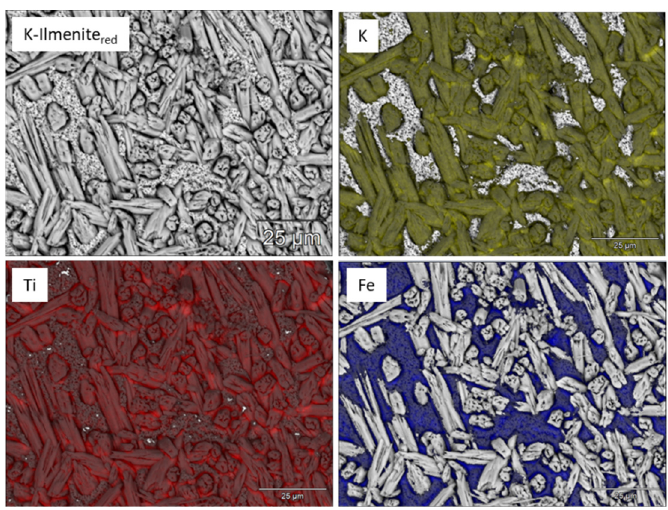
Figure 4. Back-scattered SEM image and elemental maps of K-Ilmenite red showing K (green), Ti (red), and Fe (blue). K was associated with titanium only.